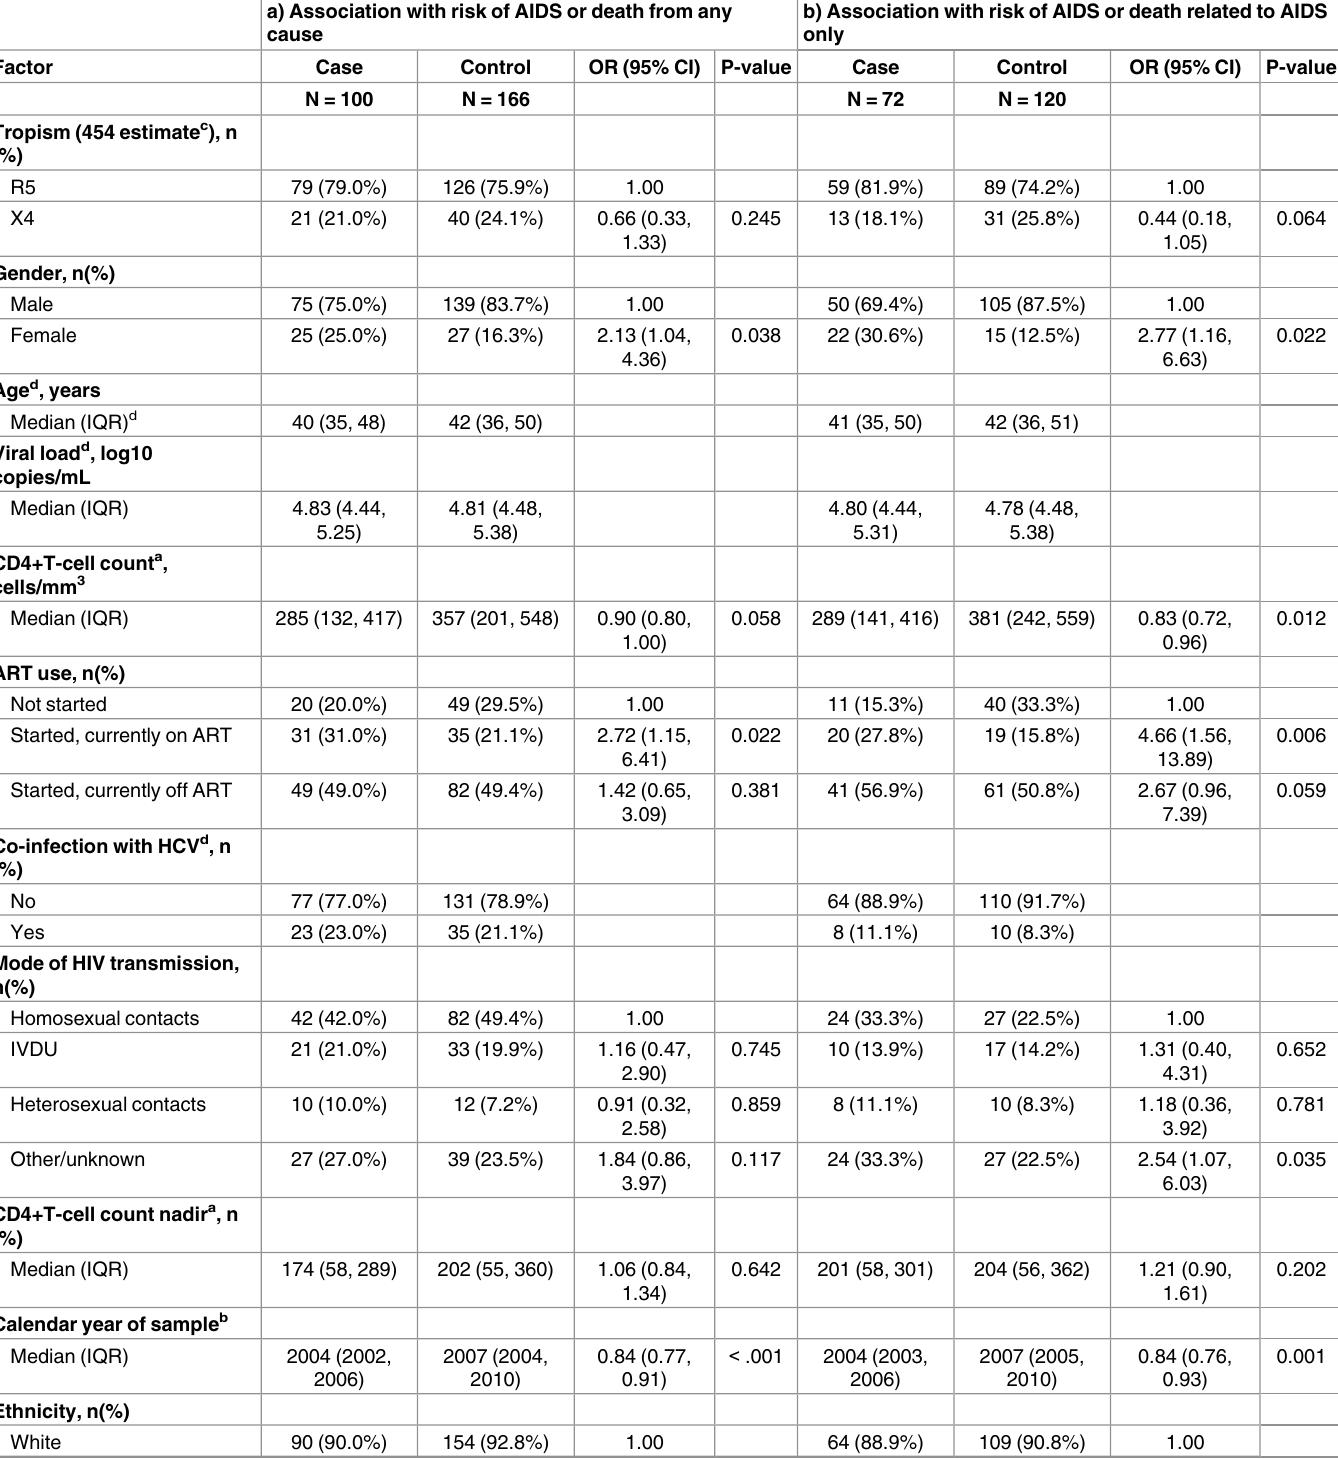
Table 2. Factors associated with risk of AIDS and/or death [a) from any cause; b) related to AIDS only] from fitting a conditional logistic regres- sion; model using 454 to infer tropism. a) Association with risk of AIDS or death from any